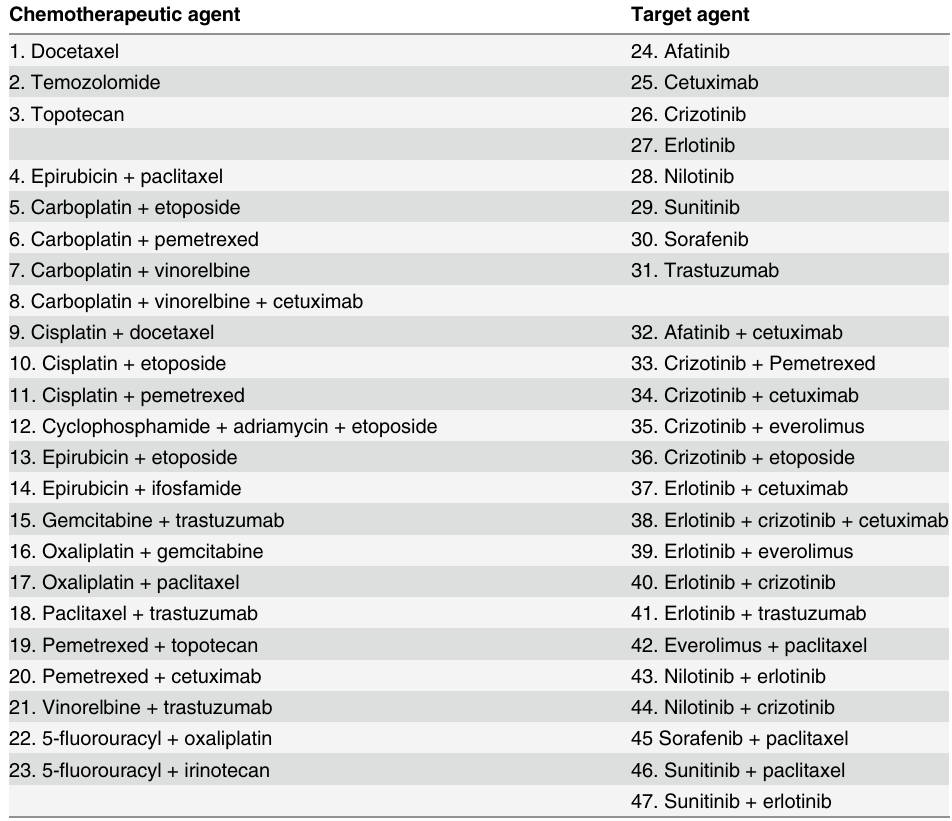
Table 1. Drugs and combinations tested in vitro